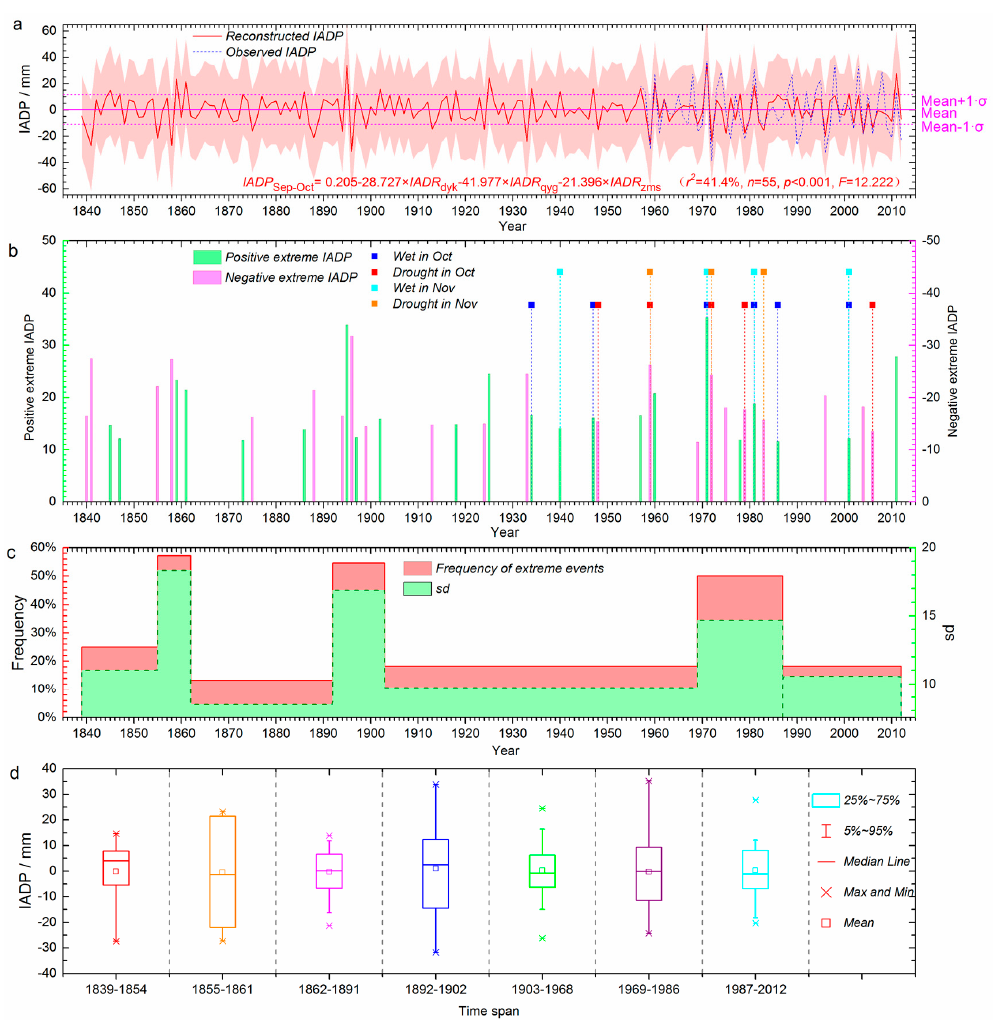
Figure 4. ( a ) Reconstructed inter-annual differences in precipitation in September–October; ( b ) comparison between extreme inter-annual changes in precipitation and extreme droughts/wetness in October and November derived from drought indices; ( c , d ) and split-period statistics for the reconstructed data.